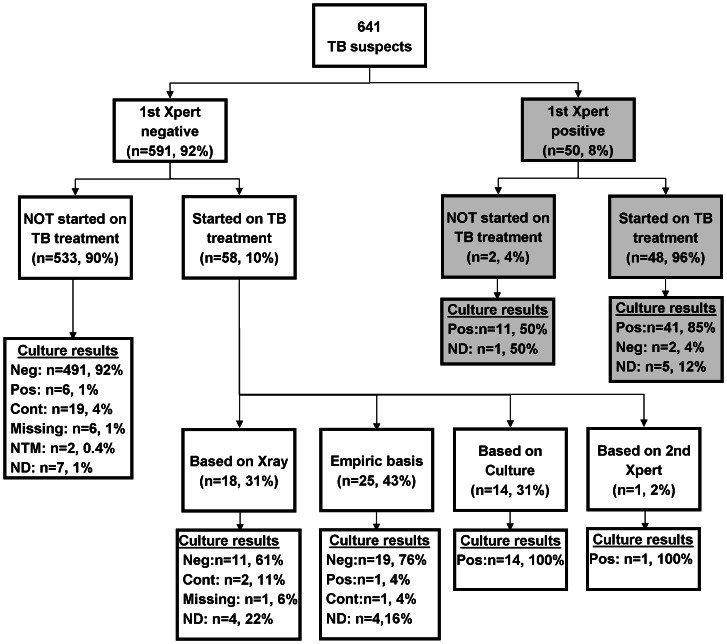
Flow chart of diagnostic assessment and basis of TB treatment initiation in 641 TB suspects presenting to a primary care clinic in Johannesburg, South Africa.The basis of diagnosis was defined as the earliest positive diagnostic test (smear, culture, Xpert or x-ray), or an empiric diagnosis if treatment was started in absence of or prior to any positive diagnostic test. Abbreviation: TB, tuberculosis; Neg, negative; Pos, positive; Cont, contaminated; NTM, non-tuberculous mycobacteria; ND, not done.